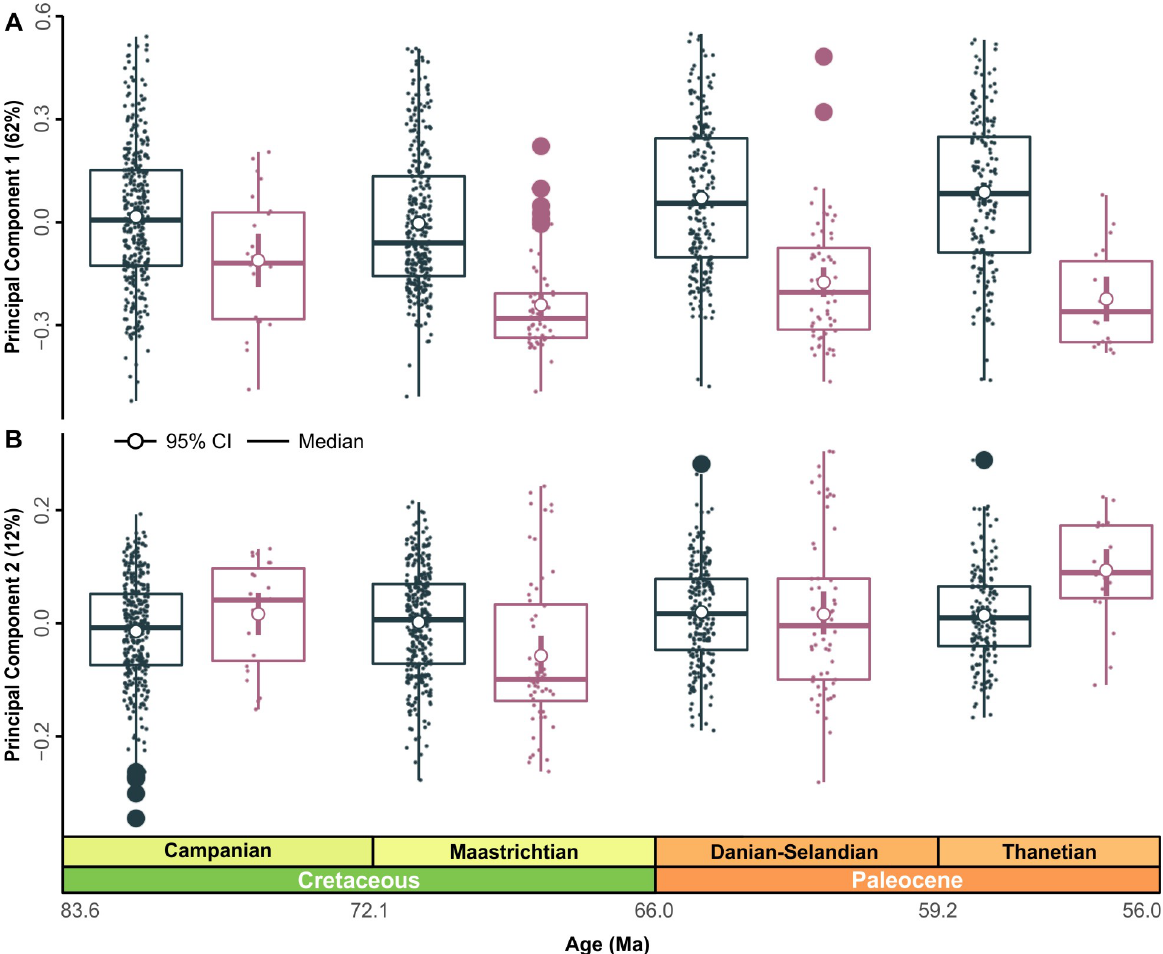
Fig 9. Superorder-level clade morphospace using the global 4-age time-binning scheme. (A–D) Jittered grouped box plots visualizing the distribution of time-bins along PC1 and PC2. Graph depicts patterns of overall shape change using the 4-age time-binning scheme. Measures of central tendency, including the median and arithmetic mean, are shown with computed 95% nonparametric bootstrap confidence intervals and potential outliers (closed black points). The data used in this analysis can be accessed online at https://doi.org/10.5061/dryad.c866t1g5n. MA, million